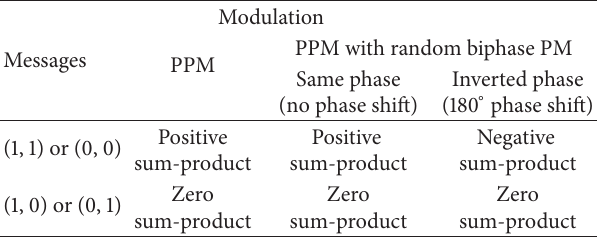
Table 1: Effects of random biphase modulation on correlation